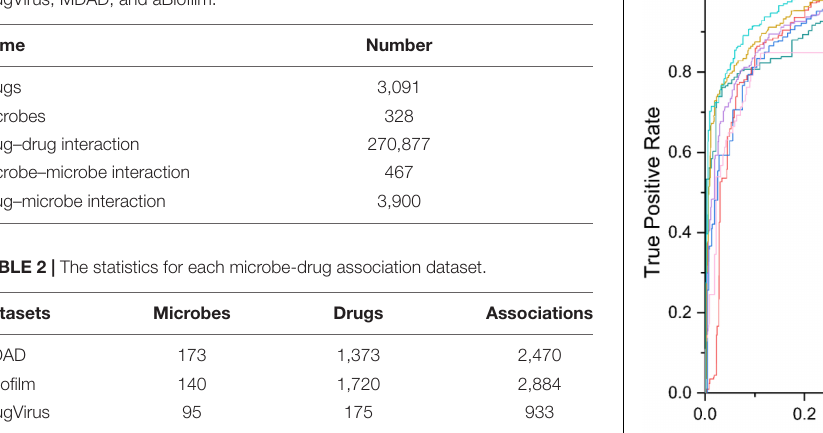
TABLE 1 | Data used in this study were obtained by integrating three datasets: DrugVirus, MDAD, and aBiofilm.